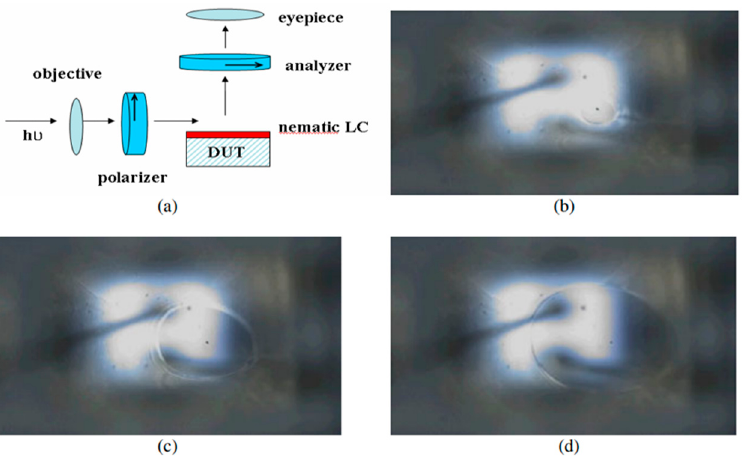
Figure 12. ( a ) Schematic setup of liquid crystal thermography measurement of GaN based blue LED. ( b – d ) Micrographs of dark gray hot spots that are above the liquid crystal transition temperature. The hot spot size increases with input power. Reprinted with permission from Ref. [176]. Copyright 2004, John Wiley and Sons.